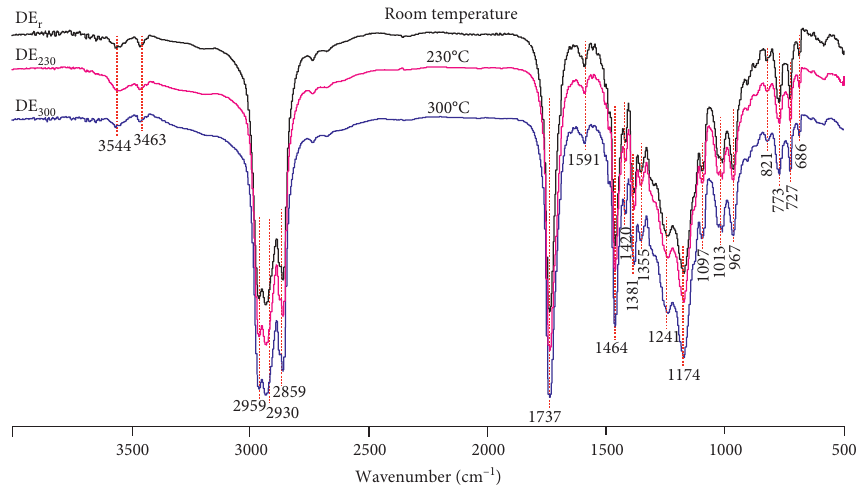
Figure 1: FTIR spectra of DE